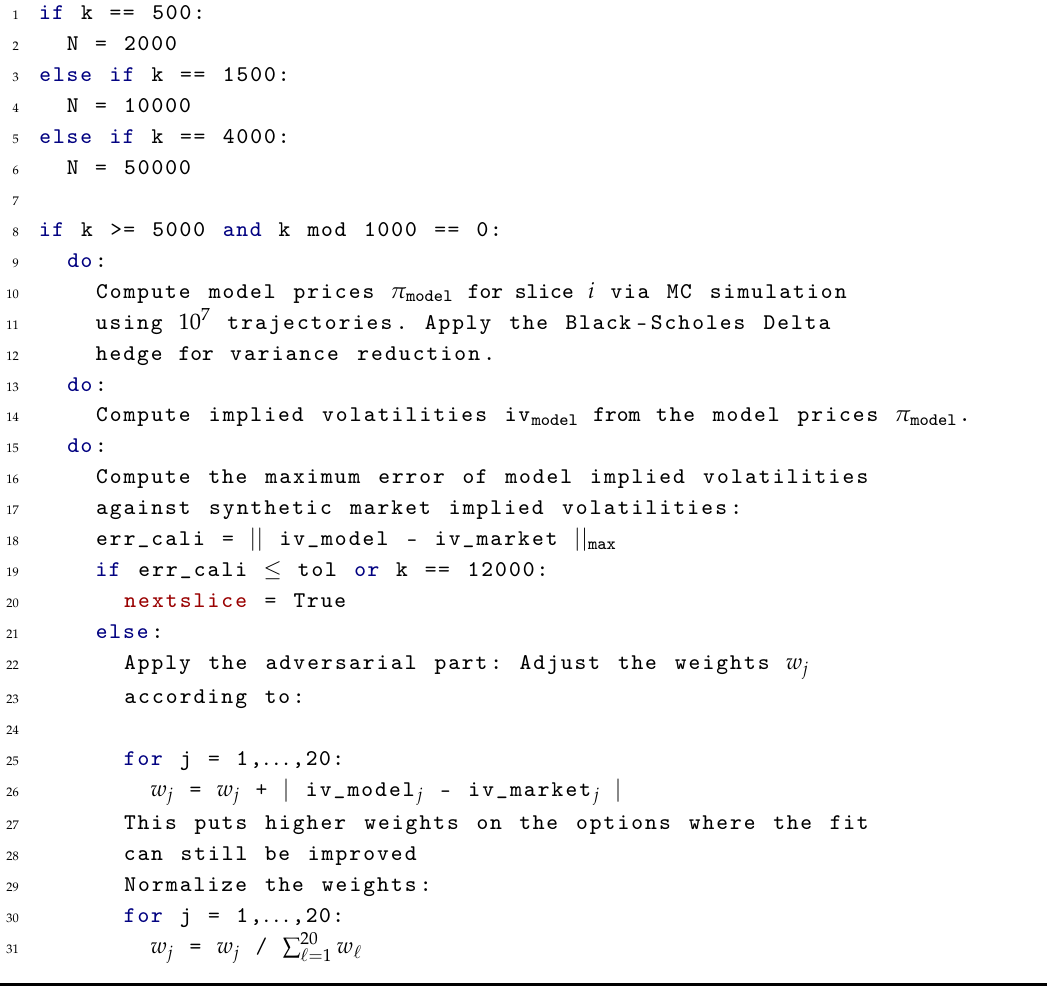
Algorithm A2: We update the parameters in Algorithm A1 according to the following